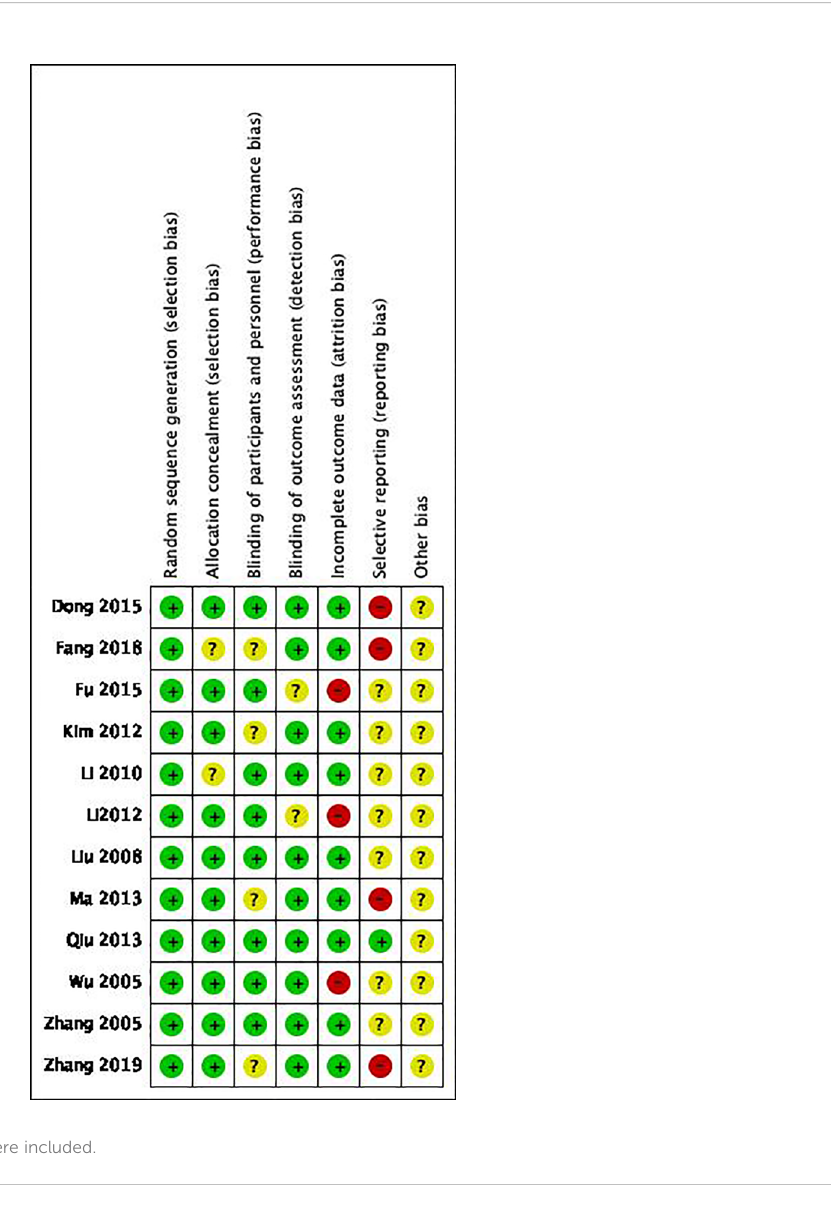
(Figure 5). The ef fi cacy of HIFU combined with TACE in the treatment of liver cancer was 1.54 times higher than that of TACE alone. The heterogeneity was evaluated by drawing Labbe plots (Figure 6). Subjective judgment of the graph showed that there was little difference in heterogeneity (the dotted line was the effective line and the red curve was the combined value). The distance between the two curves was small, so the heterogeneity was small. The circles in the fi gure represent the studies that were included. The image shows dense distribution between studies, which better represents the